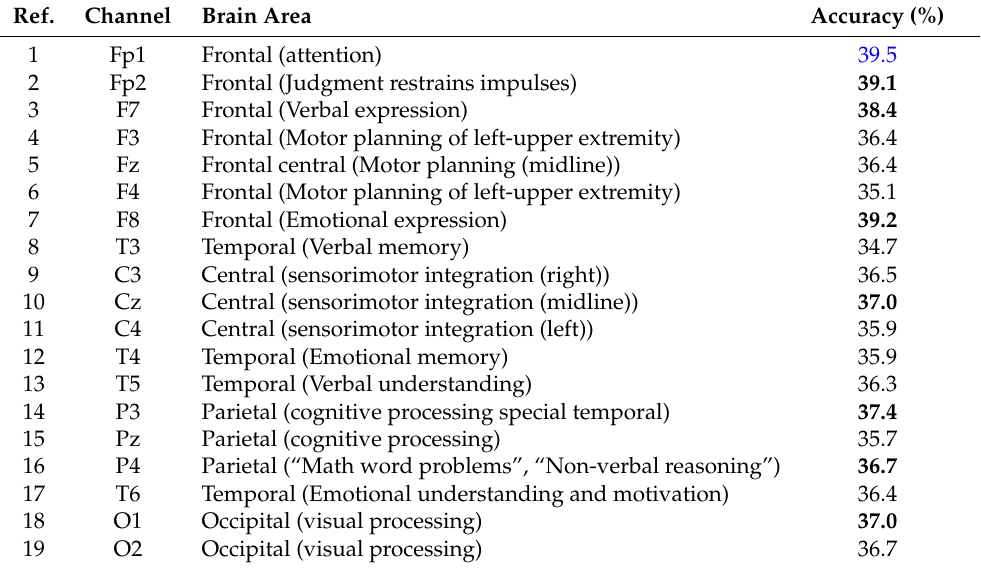
Table 7. Achieved classification accuracies by implementing the ARbC approach to constitute discriminating channel sets. The highest accuracy is highlighted in blue, while the seven highest accuracies are shown in